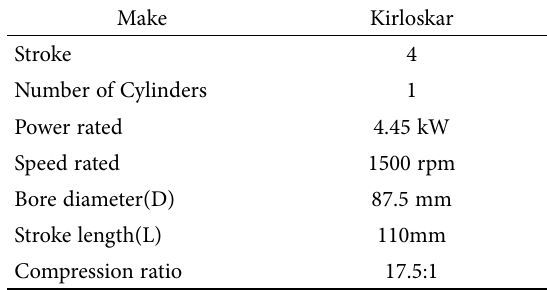
Table 3. Specifications of the engine